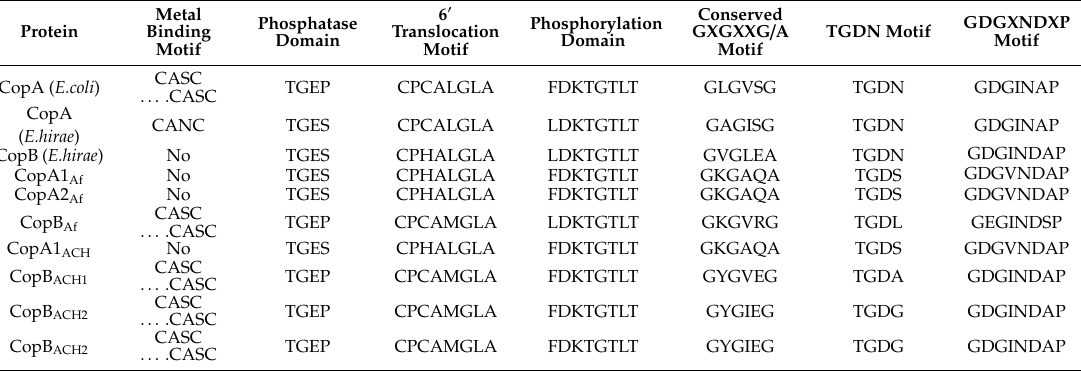
Table 2. Conserved motif identified in the CPx-type ATPases found in the A. ferrivorans ACH genome and other microorganisms with similar copper resistance systems. Af: Acidithiobacillus ferrooxidans